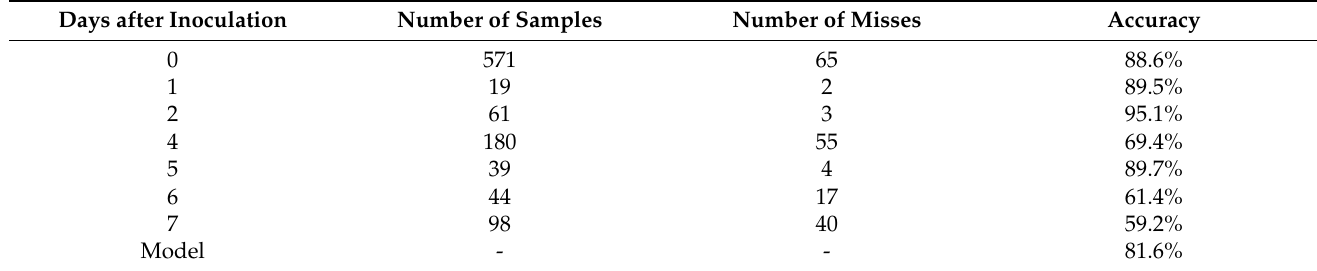
Table 7. Results by day after